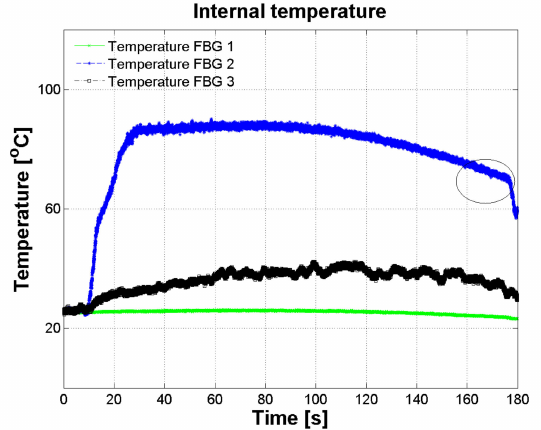
Figure 8. Inner temperatures measured by FBG temperature sensors in 180 s. Blue and black lines indicate FBG 2 and 3 in contact with the water. Green line indicates FBG 1 the temperature inside the microwave oven. Circle over blue line indicates the final temperature at the end of